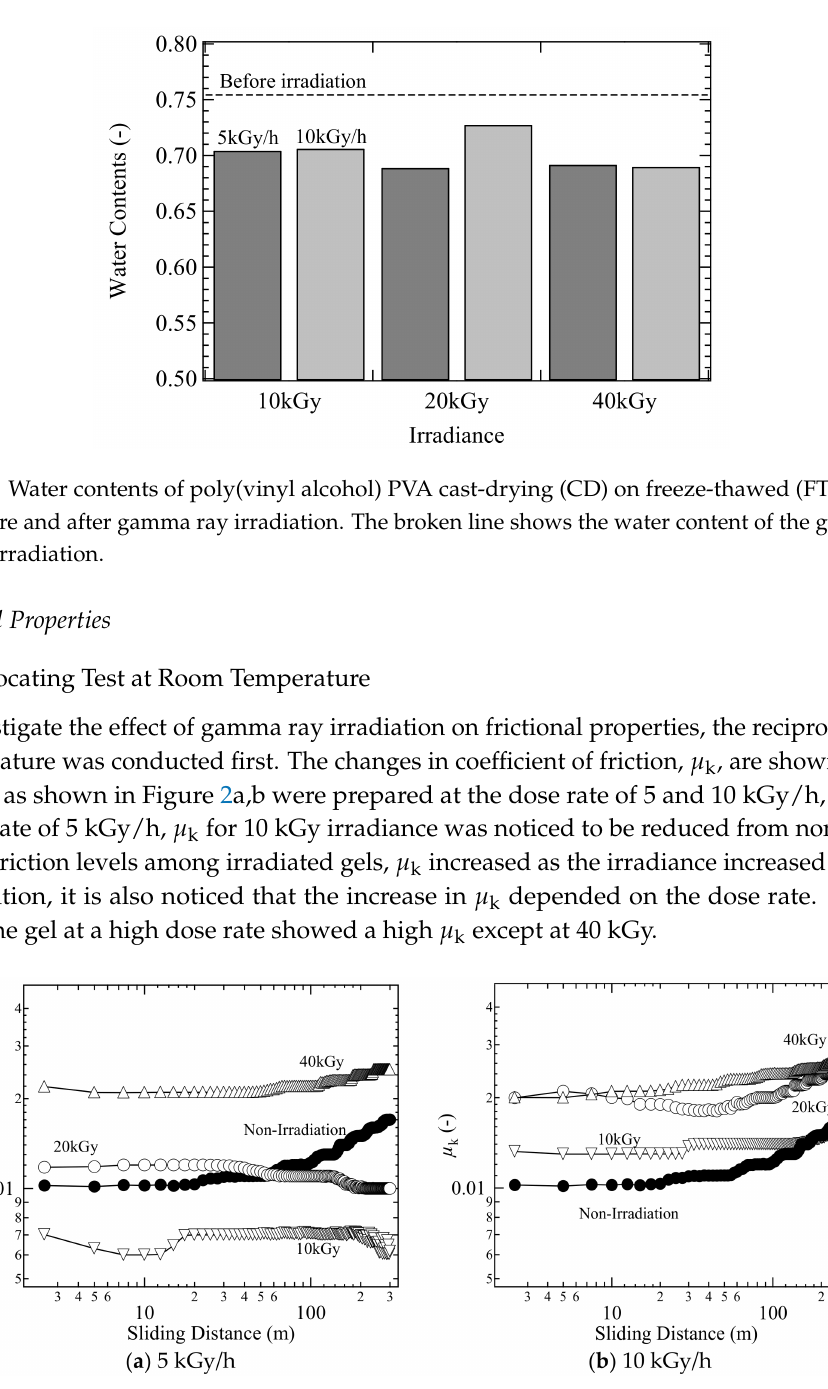
Figure 2. Coefficient of friction of gamma ray irradiated gels with ( a ) 5 kGy/h and ( b ) 10 kGy/h in reciprocating friction tests at room temperature; close circle, non-irradiation gel; inverted triangle, irradiance = 10 kGy; open circle, irradiance = 20 kGy; triangle, irradiance = 40